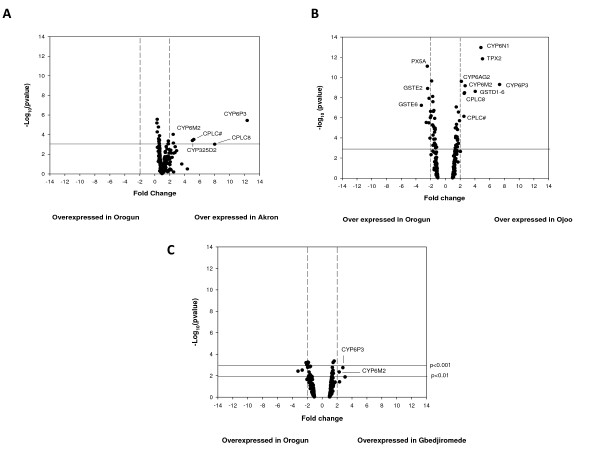
Differential expression of An. gambiae detoxification genes in pyrethroid resistant and susceptible populations. Pair-wise comparisons were made between the susceptible Orogun population and those from Akron (A), Ojoo (B) and Gbedjironmede(C). Differences are indicated as a function of both expression ratio (X-axis, vertical lines represent a 2 fold change) and significance expressed as the -log10 scale of the p-value of the t-test (y-axis, horizontal lines represent p < 0.001).